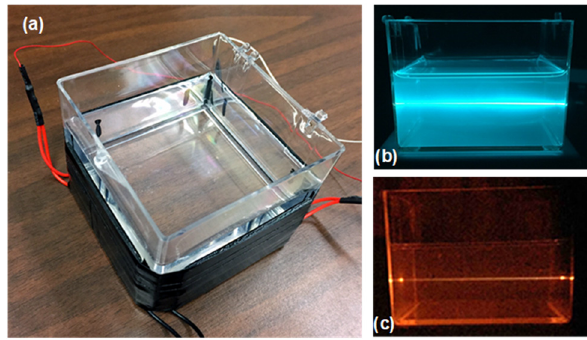
Figure 9: ( a ) LSC simulator fi lled with the nanocolloid of phosphor